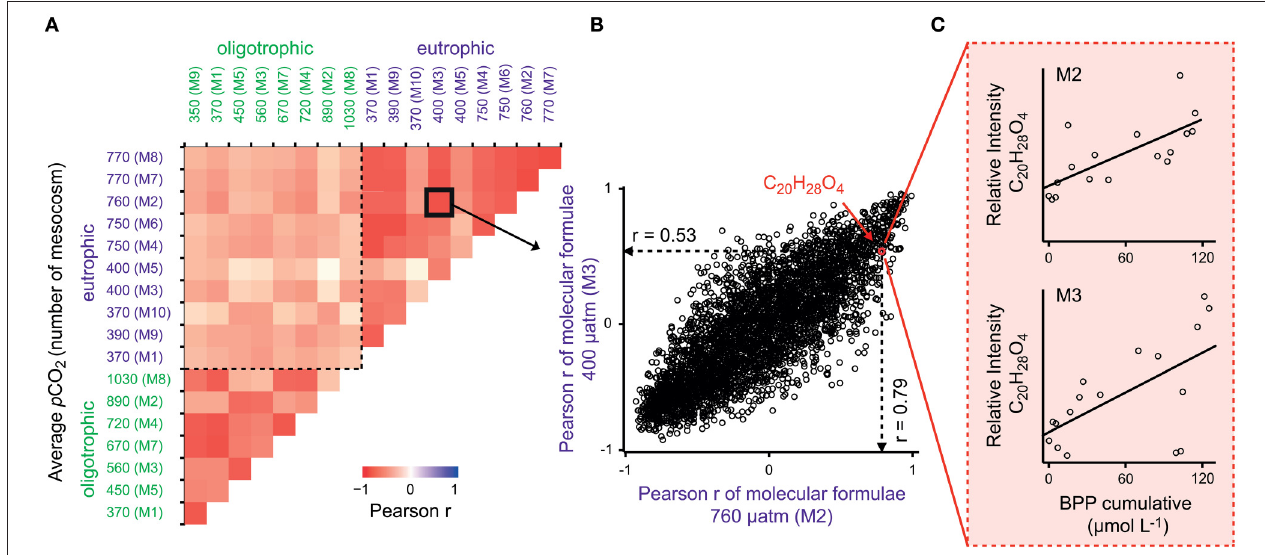
FIGURE 4 | Production of similar compounds in all mesocosms. (A) Pearson’s product-moment correlation between individual mesocosms in a coastal mesocosm study in a Swedish Fjord (Zark et al., 2015a) and in the presented oligotrophic mesocosm experiment. The calculation is based on (B) Pearson product-moment correlation coefficients ( r ) from (C) correlation of relative signal intensities of molecular formulae with cumulative BPP. This statistical analysis illustrates the similarities in succession of molecular compounds between the experiments. The color scale displays the Pearson correlation coefficient ( r ) with values between − 1 (negative linear relation) and 1 (positive linear relation). Similar compounds correlate with cumulative BPP in all mesocosms with an overall highly significant correlation of r = 0.45 ( p < 0.0001, n = 3,972).